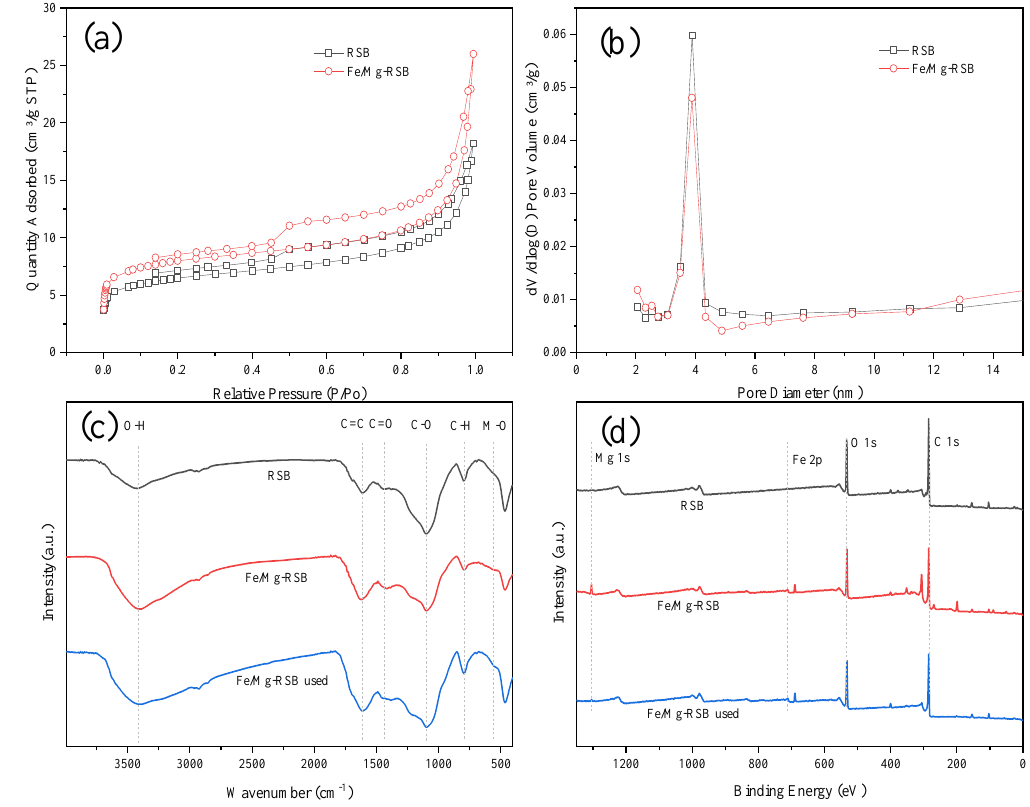
Figure 2. Nitrogen adsorption – desorption isotherms ( a ). Pore size distribution ( b ). FTIR ( c ) and XPS survey ( d ) of biochars.